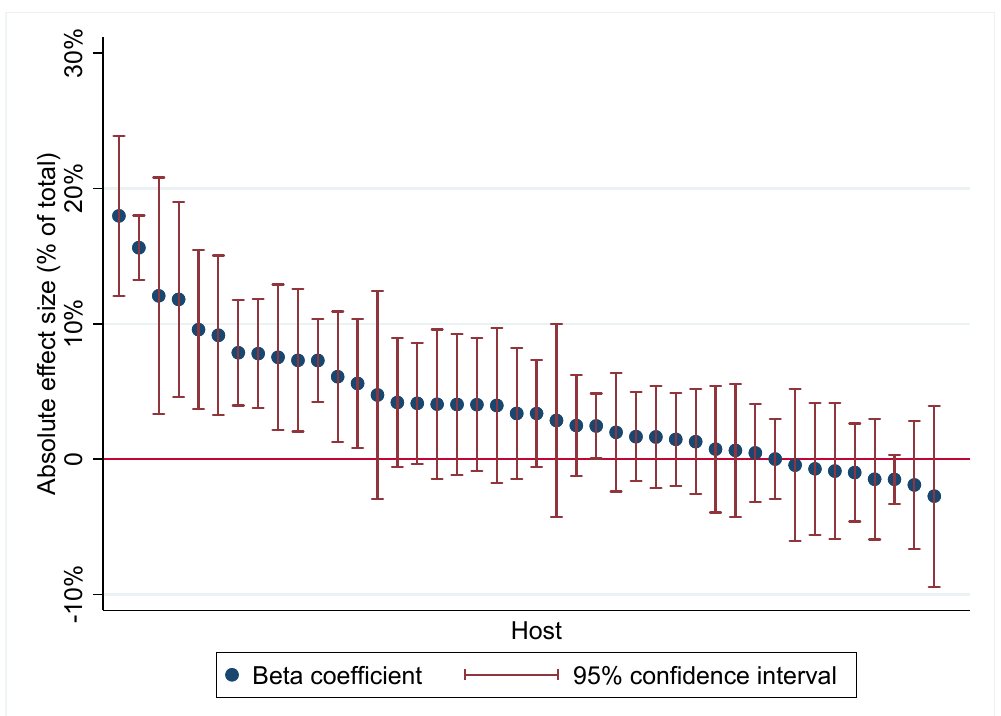
Figure 5. Effect size by host.